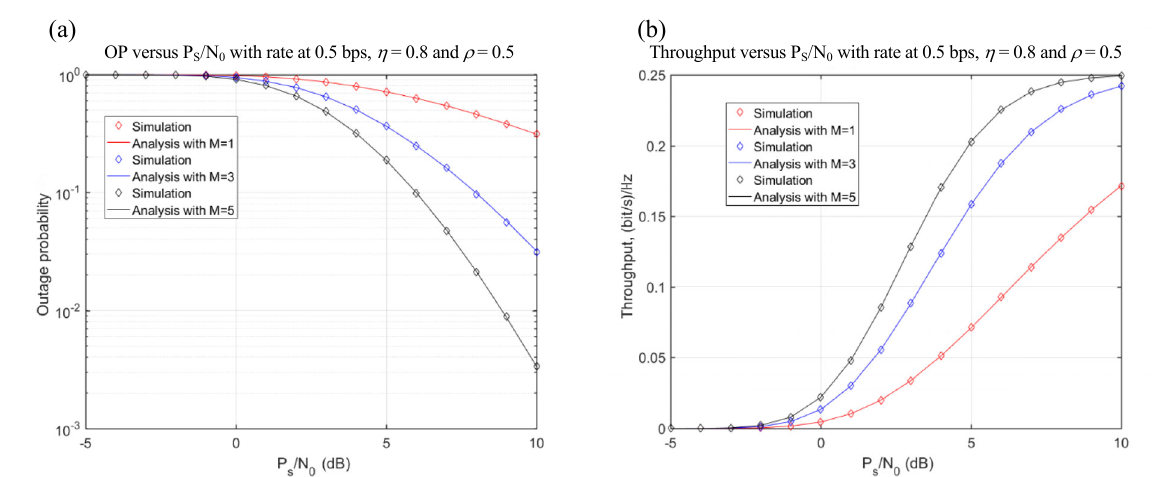
Fig. 6. Outage probability (a) and achievable throughput (b) versus the source power to noise ratio P S / N 0 .